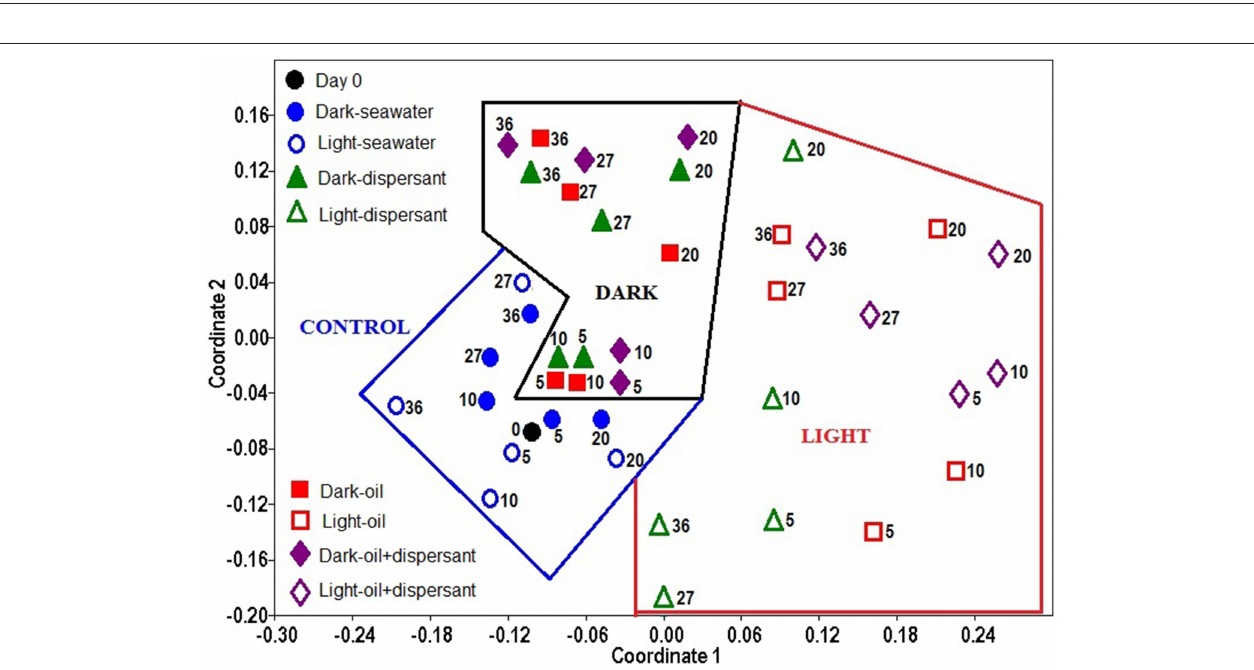
FIGURE 4 | Non- metric multidimensional scaling (NMDS) of bacterial community structures in light and dark conditions. The ordination is based on Bray-Curtis coefficient matrix of relative abundances. The numbers indicate days of incubation.